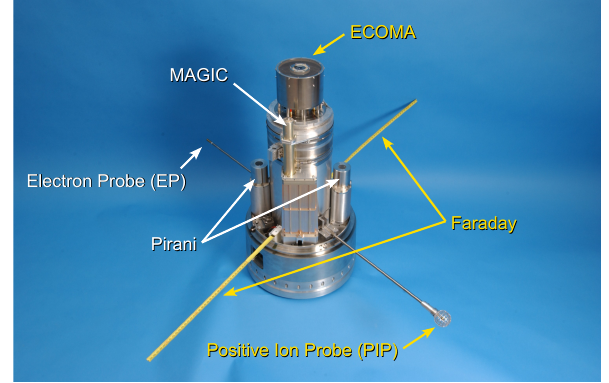
Fig. 1. Top deck (front) of the ECOMA payloads. The instruments used in this analysis have yellow labels. The ECOMA instrument measures charged aerosol particles ( > 2nm), the PIP (Positive Ion Probe) measures positive ion density, while the Faraday instrument measures absolute electron density by Faraday